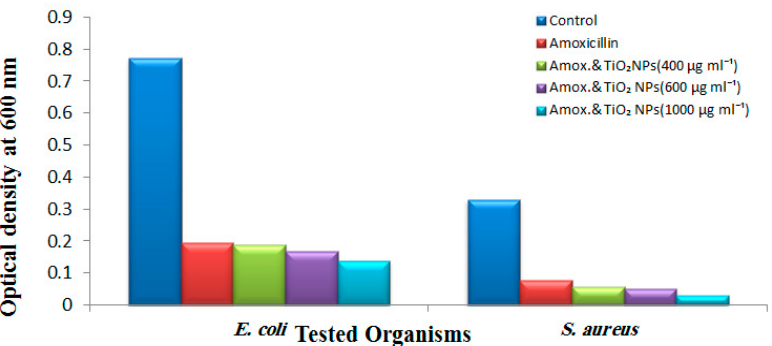
Figure 9. Growth of the tested bacteria in the presence of amoxicillin and TiO 2 NPs measured at 600 nm.